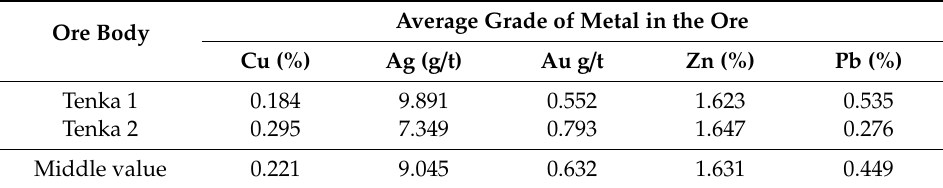
Table 1. Average grade of metal in the deposit of polymetallic ore Tenka. Average Grade of Metal in the Ore Body